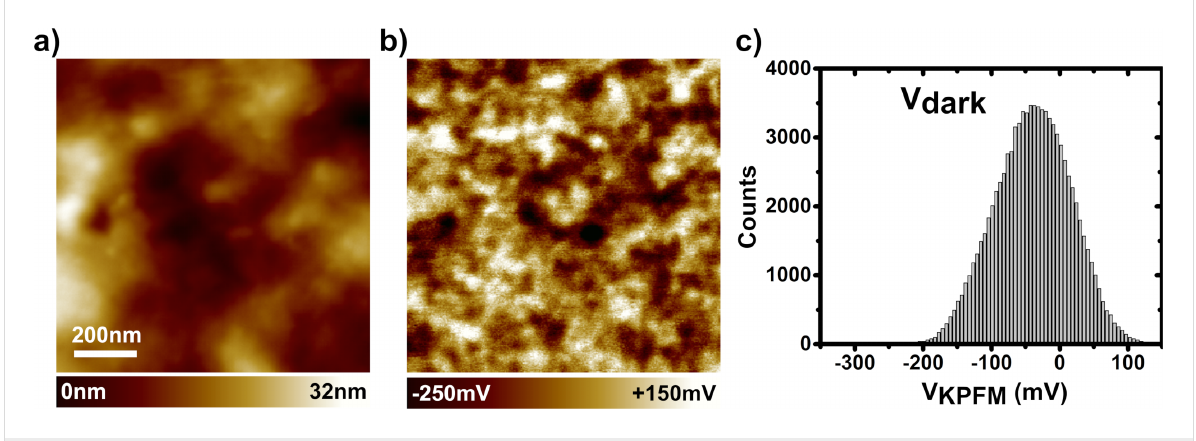
Figure 7: (a) Topographic (nc-AFM, UHV, 300 K) and (b) KPFM compensation potential images (1 μ m × 1 μ m, 300 × 300 pixels) of the PTB7:PC 71 BM blend recorded in the dark (standard KPFM configuration). (c) Histogram of the KPFM potential